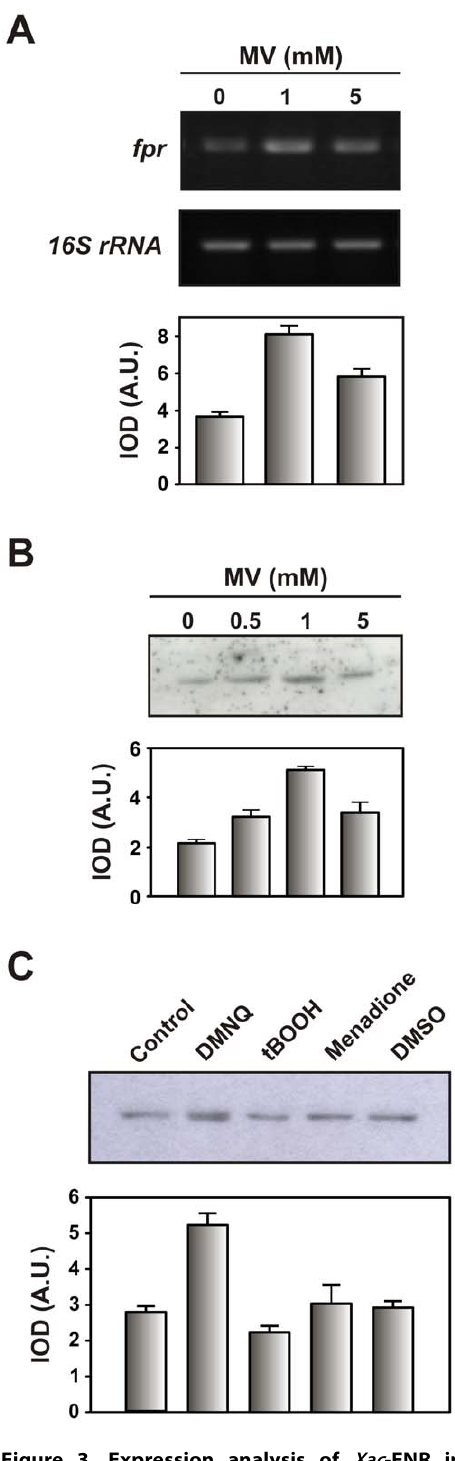
Figure 3. Expression analysis of Xac -FNR in response to oxidative treatments. (A) Amplified products of the Xac fpr gene by semiquantitative RT-PCR using RNA preparations from Xanthomonas axonopodis pv. citri cultures grown in SB medium to the early exponential phase and exposed to the indicated concentrations of MV for 15 min. 16S rRNA was used as a loading control and for the quantitation of the total RNA in the RT-PCR experiments. (B) Xac -FNR accumulation after MV-dependent induction. Cleared extracts corre- spond to 25 m g of total soluble protein. Samples were analyzed by SDS- PAGE and immunoblot analysis using specific antisera. (C) Effect of 2,3- dimetoxy-1,4-naphthoquinone (DMNQ) 500 m M, tert-butyl